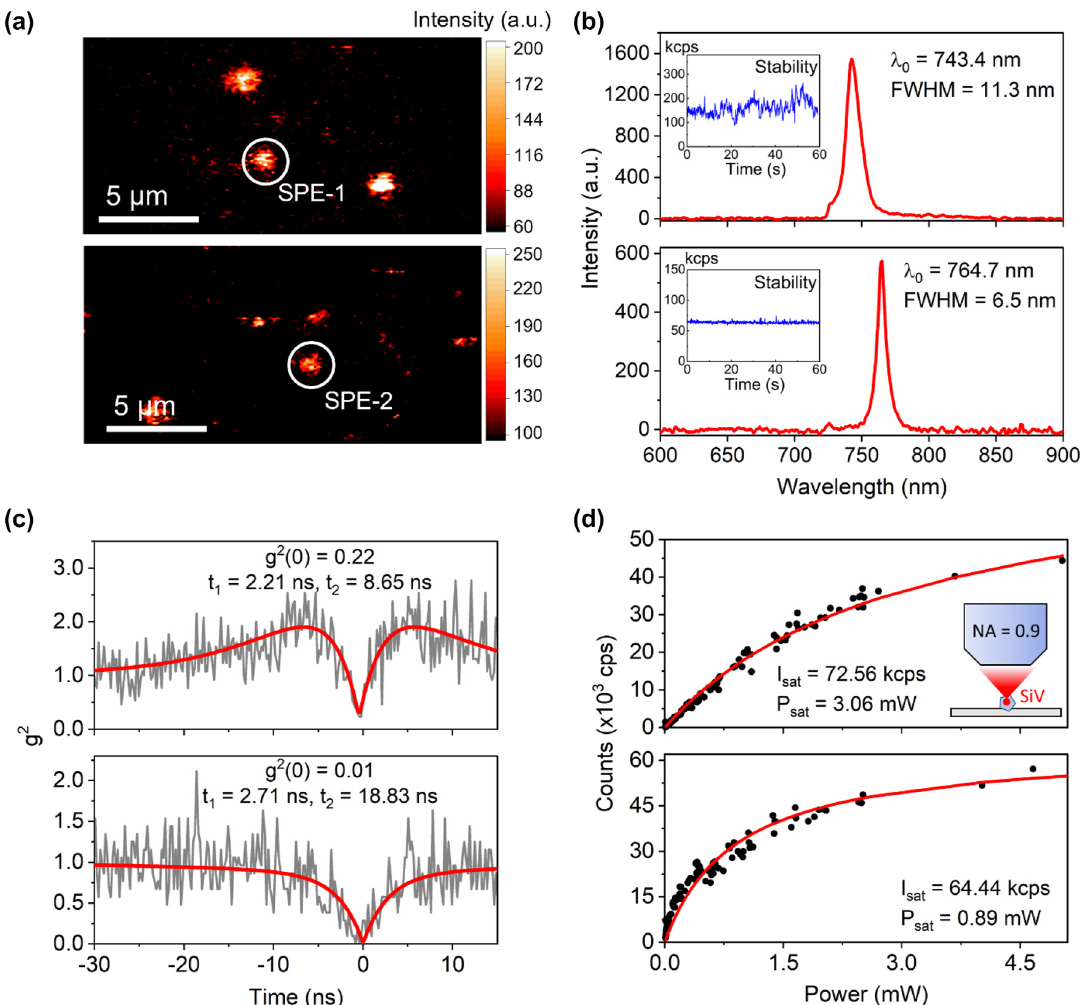
Figure 3: Photophysics of typical single-photon emitters (SPEs) found on sample D. (a) Two PL maps containing bright, stable emitters collected on sample D under a 690 nm CW laser excitation. (b) The emission spectra of emitter SPE-1 (top) and SPE-2 (bottom) circled in (a) under the excitation of the 690 nm CW laser. Insets are the fluorescence stability curves of both emitters recorded for 60 s. (c) Second-order autocorrelation measurement of SPE-1 (top) and SPE-2 (bottom). Gray lines are experimental data and red lines are fitted curves using the three-level model mentioned in the main text. , and t . (d) Fluorescence saturation curves of typical SPEs found on sample D, showing saturation The graph indicates the fitted values of g (2) (0), t 1 2 counts of around 70 kcps. Solid black dots are experimental data and red lines are fitted curves. Inset: a schematic illustrating the collection configurations used for SiV centers in NDs on a quartz